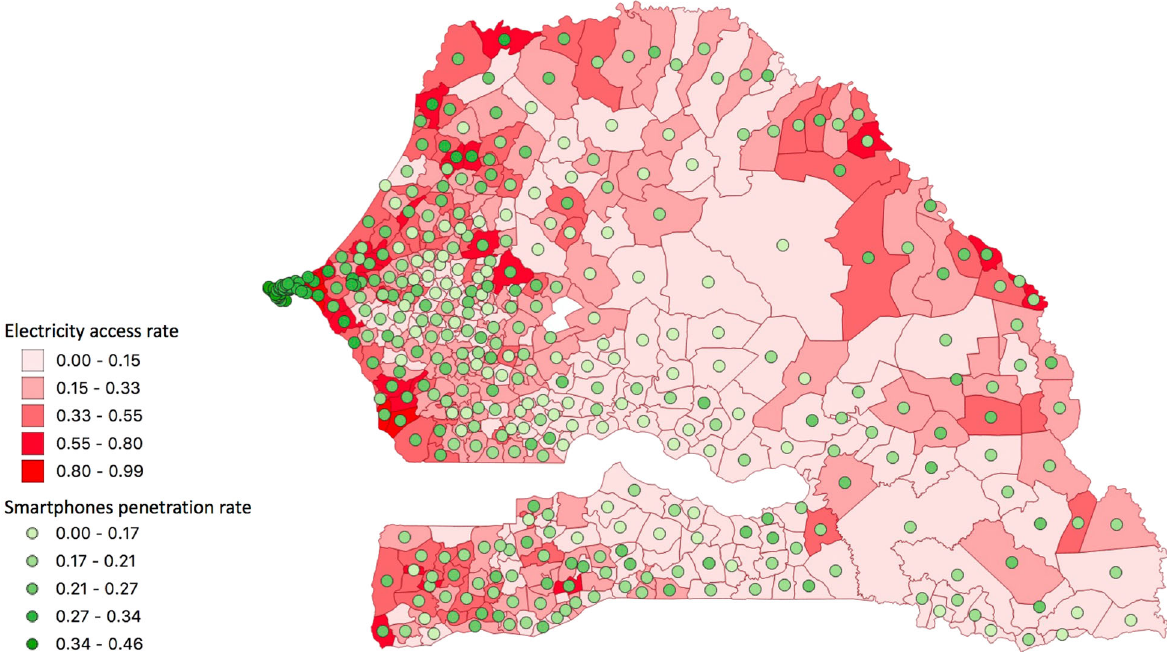
Fig. 2 Rate of access to electricity and smartphone penetration. Senegalese municipalities are coloured by electricity access rate. Green dots indicate smartphone penetration rate in the corresponding